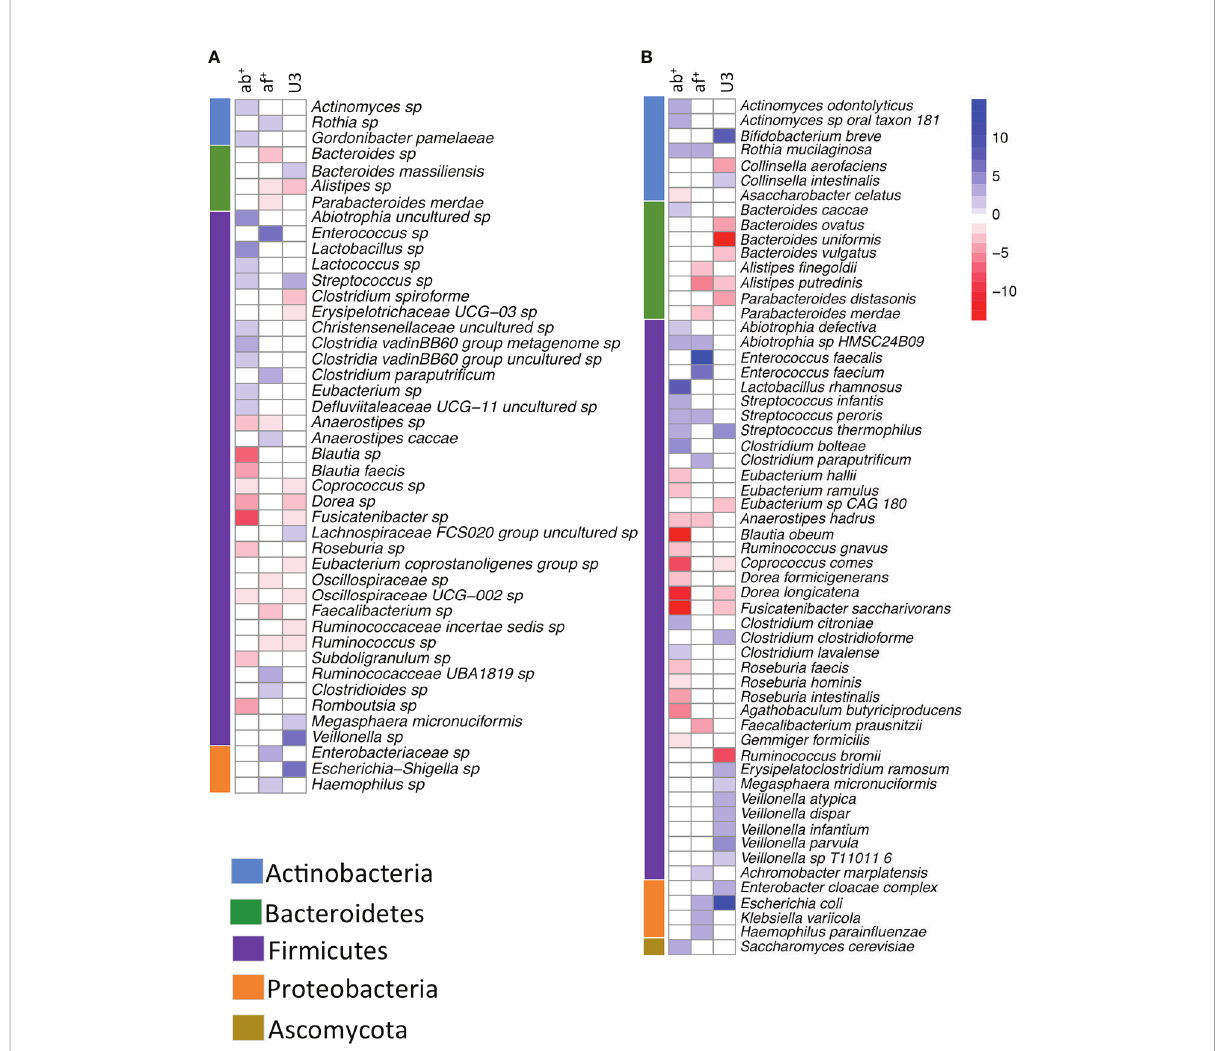
FIGURE 3 Heatmap showing taxa signi fi cantly (FDR corrected p<0.05) associated with antibiotic use, antifungal use and age category in a multivariate analysis using (A) 16S rRNA gene data and (B) whole shotgun metagenome data. Intensity of change is determined as the negative log of the q- value *coef fi cient of change, blue indicates taxa increased with antibiotic use (ab+), antifungal use (af+) or in the under 3 age group (U3) and red are taxa decreased with antibiotic use (ab+), antifungal use (af+) or in the under 3 age group (U3). Taxa are sorted by phyla, which are indicated in the bar adjacent to the